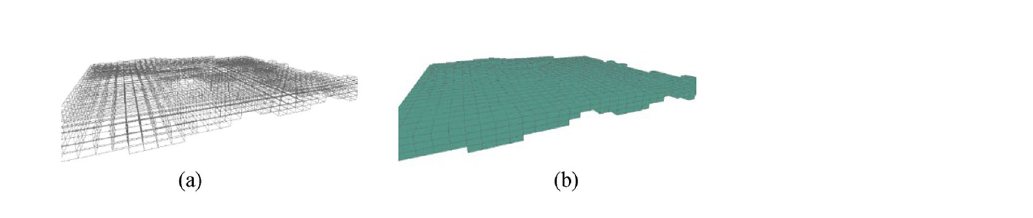
Figure 16. Rendering regular voxels.